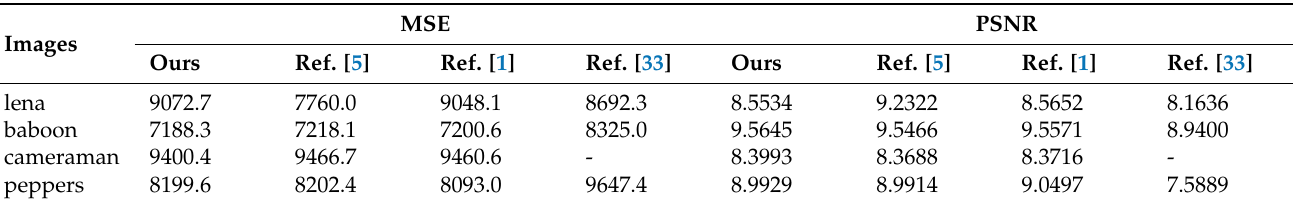
Table 6. The MSE and PSNR values of encrypted images with different approach.